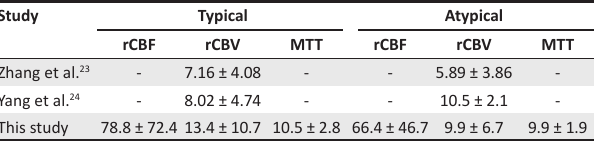
TABLE 6: A comparison between the mean perfusion parameters of typical and atypical meningiomas in previous studies and this study. Study Typical